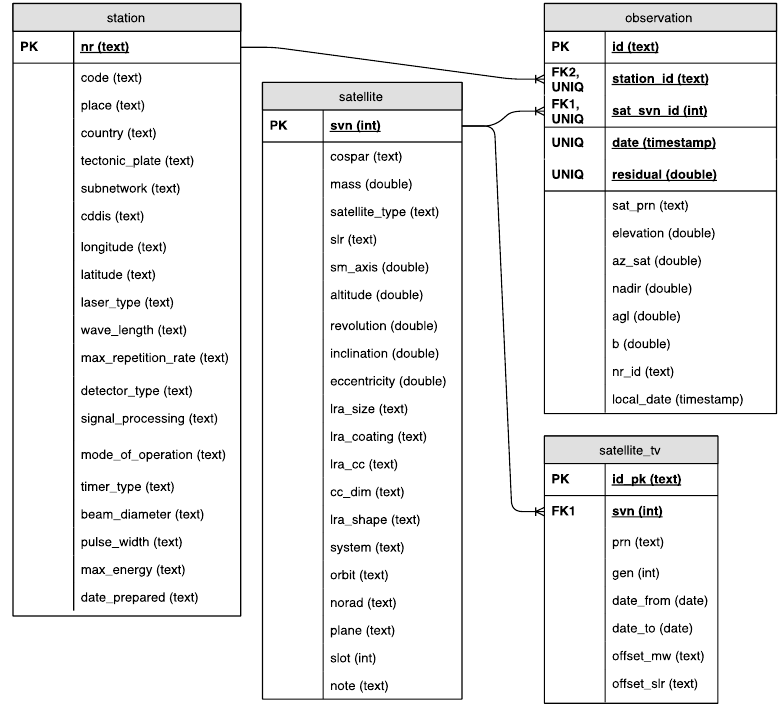
Figure 3. Partial scheme of the GOVUS database, used in the web application. Abbreviations used: PK, primary key; FK, foreign key, UNIQ, unique value; int, integer; double, double-precision floating-point number.